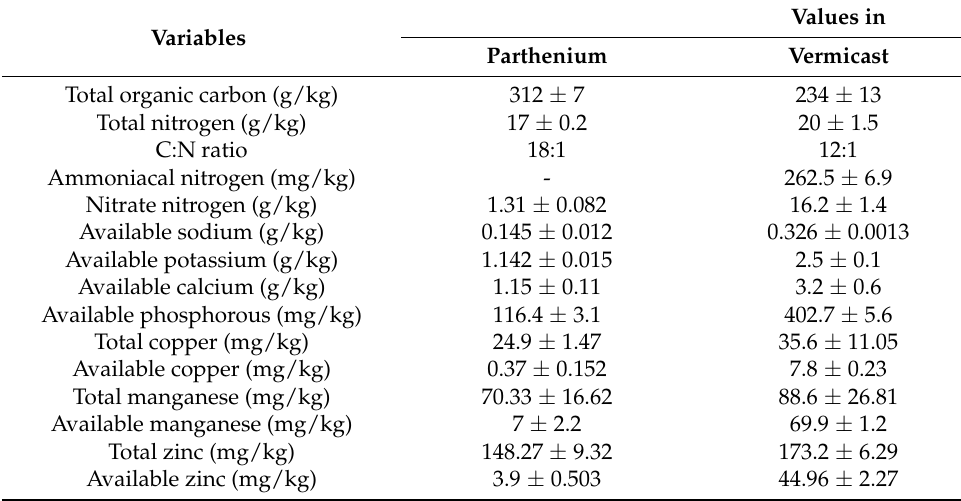
Table 9. Chemical characteristics of parthenium and its